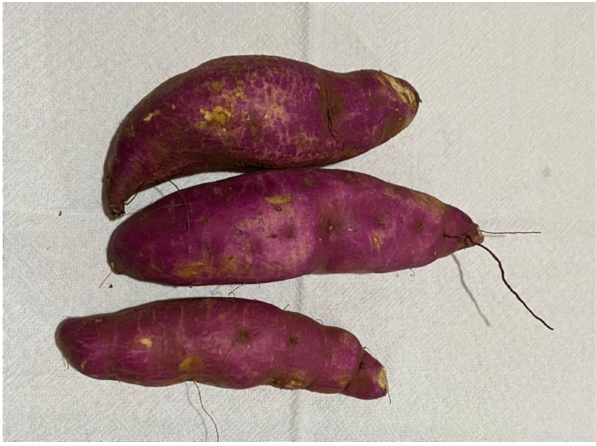
Figure 1. Sweet potato, Ipomoea batatas L. Source: Personal